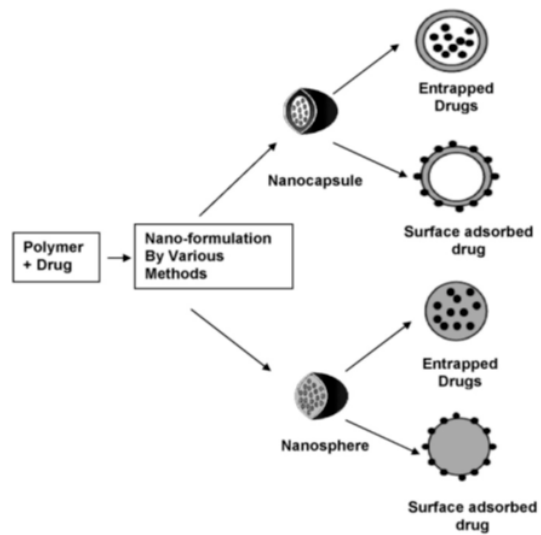
Figure 5. Differential morphology of the types of NPs employed for polymeric insulin delivery (reproduced with permission from Reference [52]).